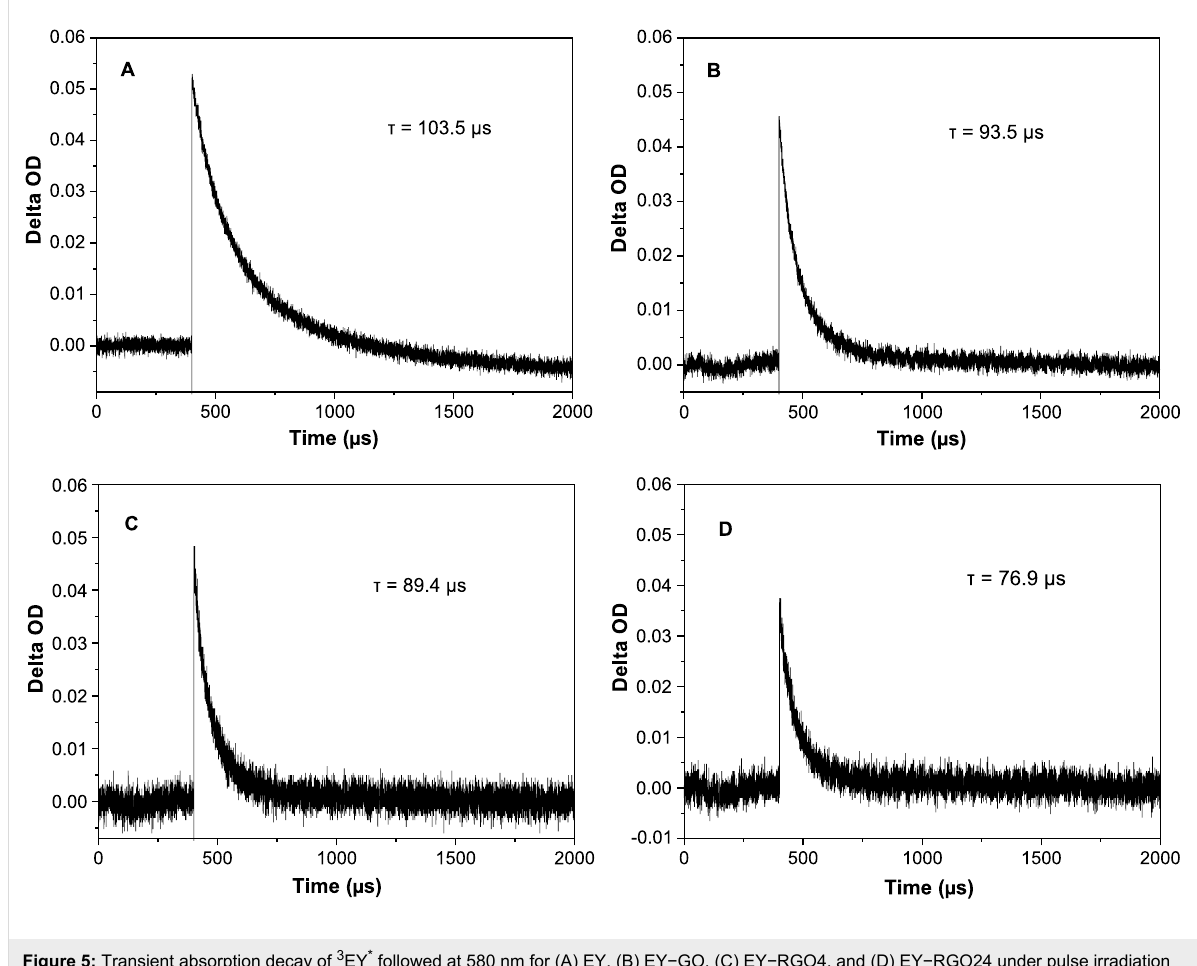
Figure 5: Transient absorption decay of 3 EY * followed at 580 nm for (A) EY, (B) EY − GO, (C) EY − RGO4, and (D) EY − RGO24 under pulse irradiation of 532 nm. Conditions: 30 μ g mL − 1 GO or RGO x ; 2.0 × 10 − 5 mol L − 1 EY.